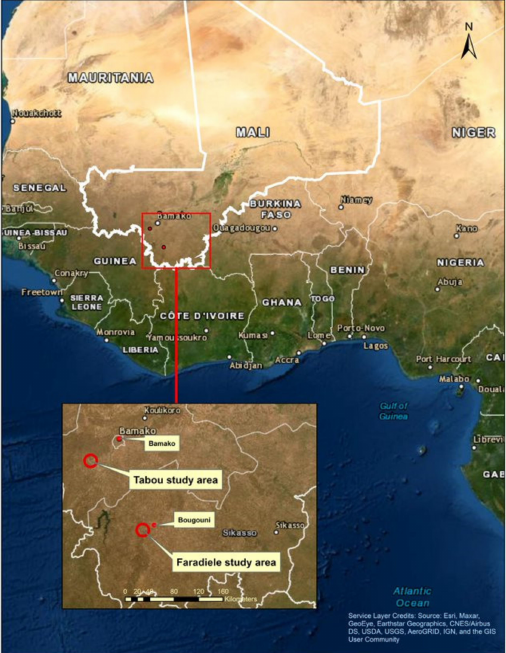
Figure 5. Study areas of Tabou and Faradi é l é in southern Mali (Figure by S. Winslow). The vegetation is in the southern Sudanian savanna and is predominantly composed of a mixture of grasses, trees, and shrubs arranged in a complex mosaic. The landscape heterogeneity is a function of underlying soil and hydrology, as well as its agricultural uses, the combinations of which produce unique patterns of land cover (Figure 6)